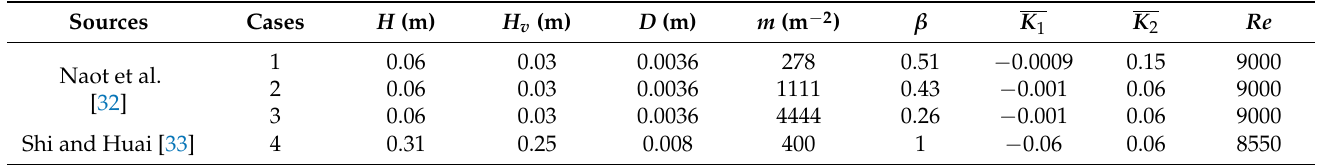
Table 1. Summary of the experimental